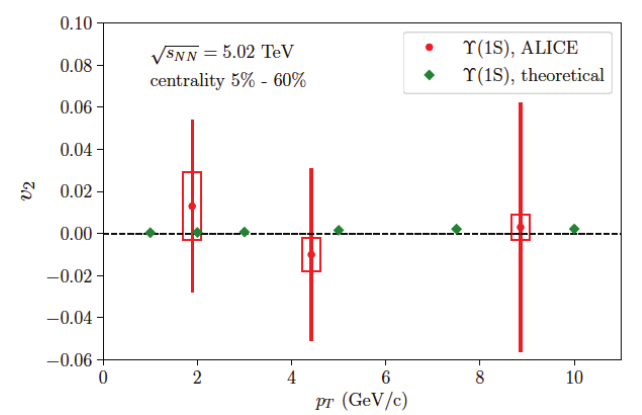
Figure 14. The ellipticity v 2 ( p T ) of the Υ ( 1 S ) momentum distribution in 5–60% Pb-Pb collisions √ s NN = 5.02 TeV as calculated from anisotropic escape is consistent with zero, green symbols. at (From Fritsch, BSc thesis HD 2020, unpublished. Reproduced with permission.) The data (red) are from ALICE